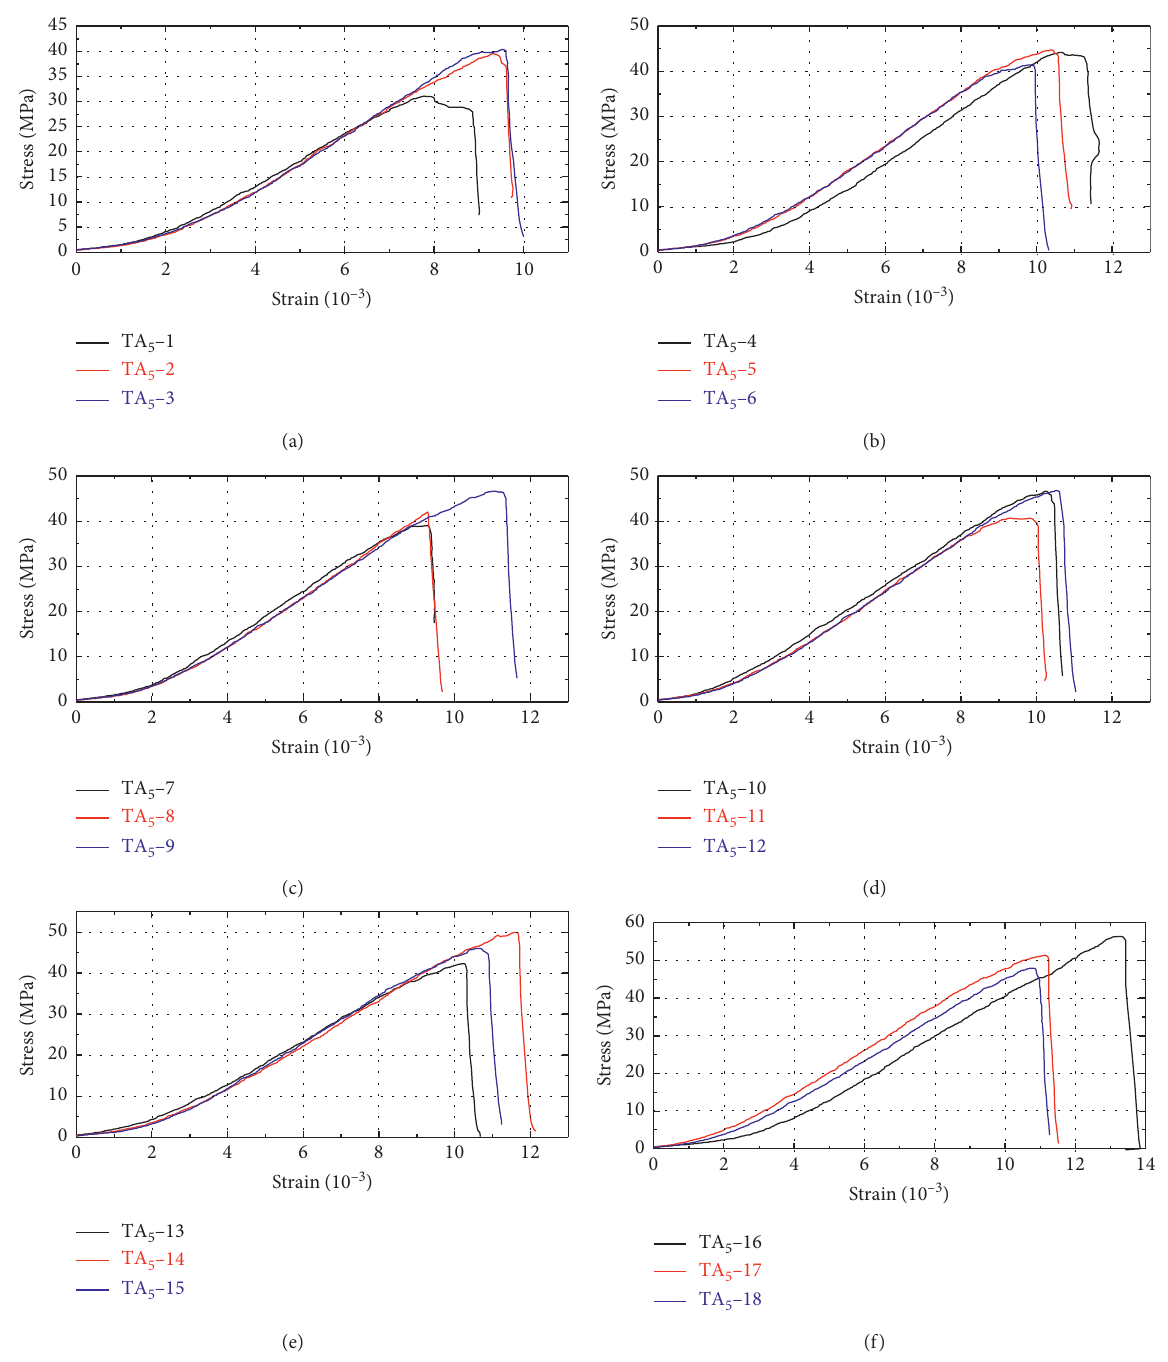
Figure 4: Effects of heterogeneity on the stress-strain curves of specimens containing two preexisting parallelogram flaws. (a) Specimen containing two flaws with the same area ( α � β � 45 ° ). (b) Specimen containing two flaws with the same area ( α � 45 < β � 60 ° ). (c) Specimen containing two flaws with the same area ( α � 45 < β � 75 ° ). (d) Specimen containing two flaws with the same area ( α � β � 60 ° ). (e) Specimen containing two flaws with the same area ( α � 60 < β � 75 ° ). (f) Specimen containing two flaws with the same area ( α � β � 75 °